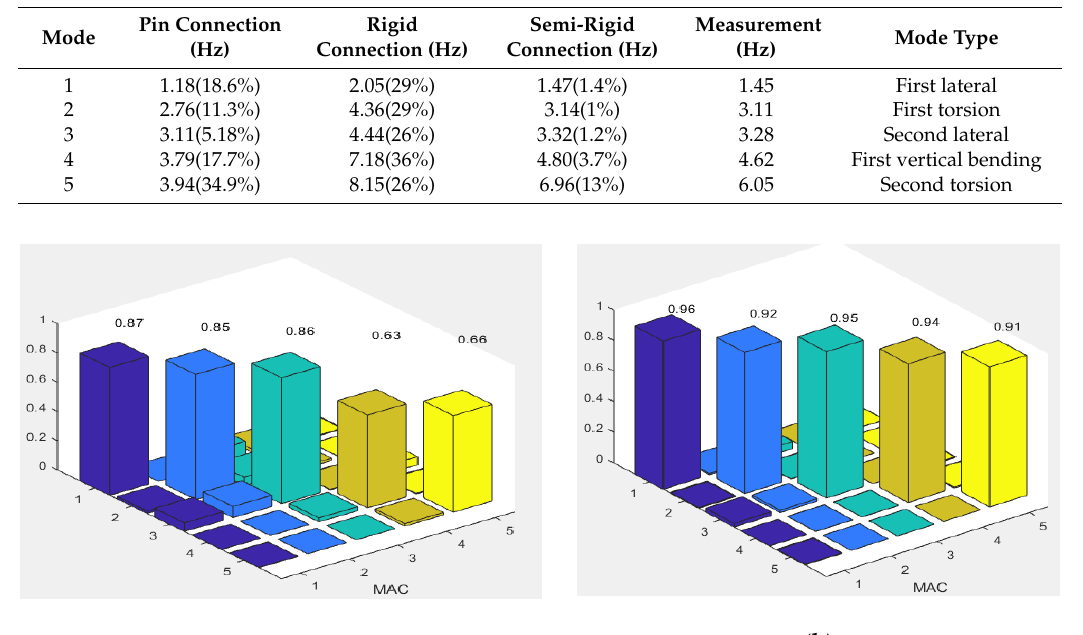
Table 4. The natural frequencies from the FE model for three connection cases, and from measurements.